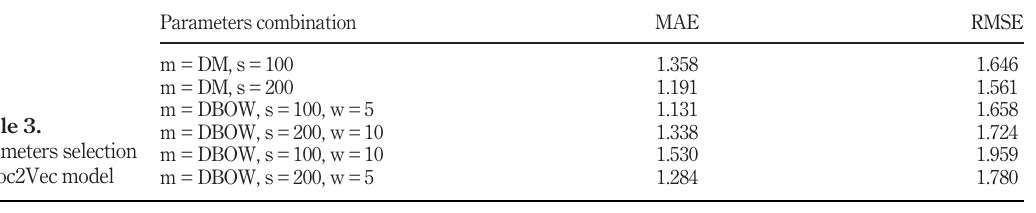
Table 4. The comparison of DM-DBOW and SAE þ DM-DBOW